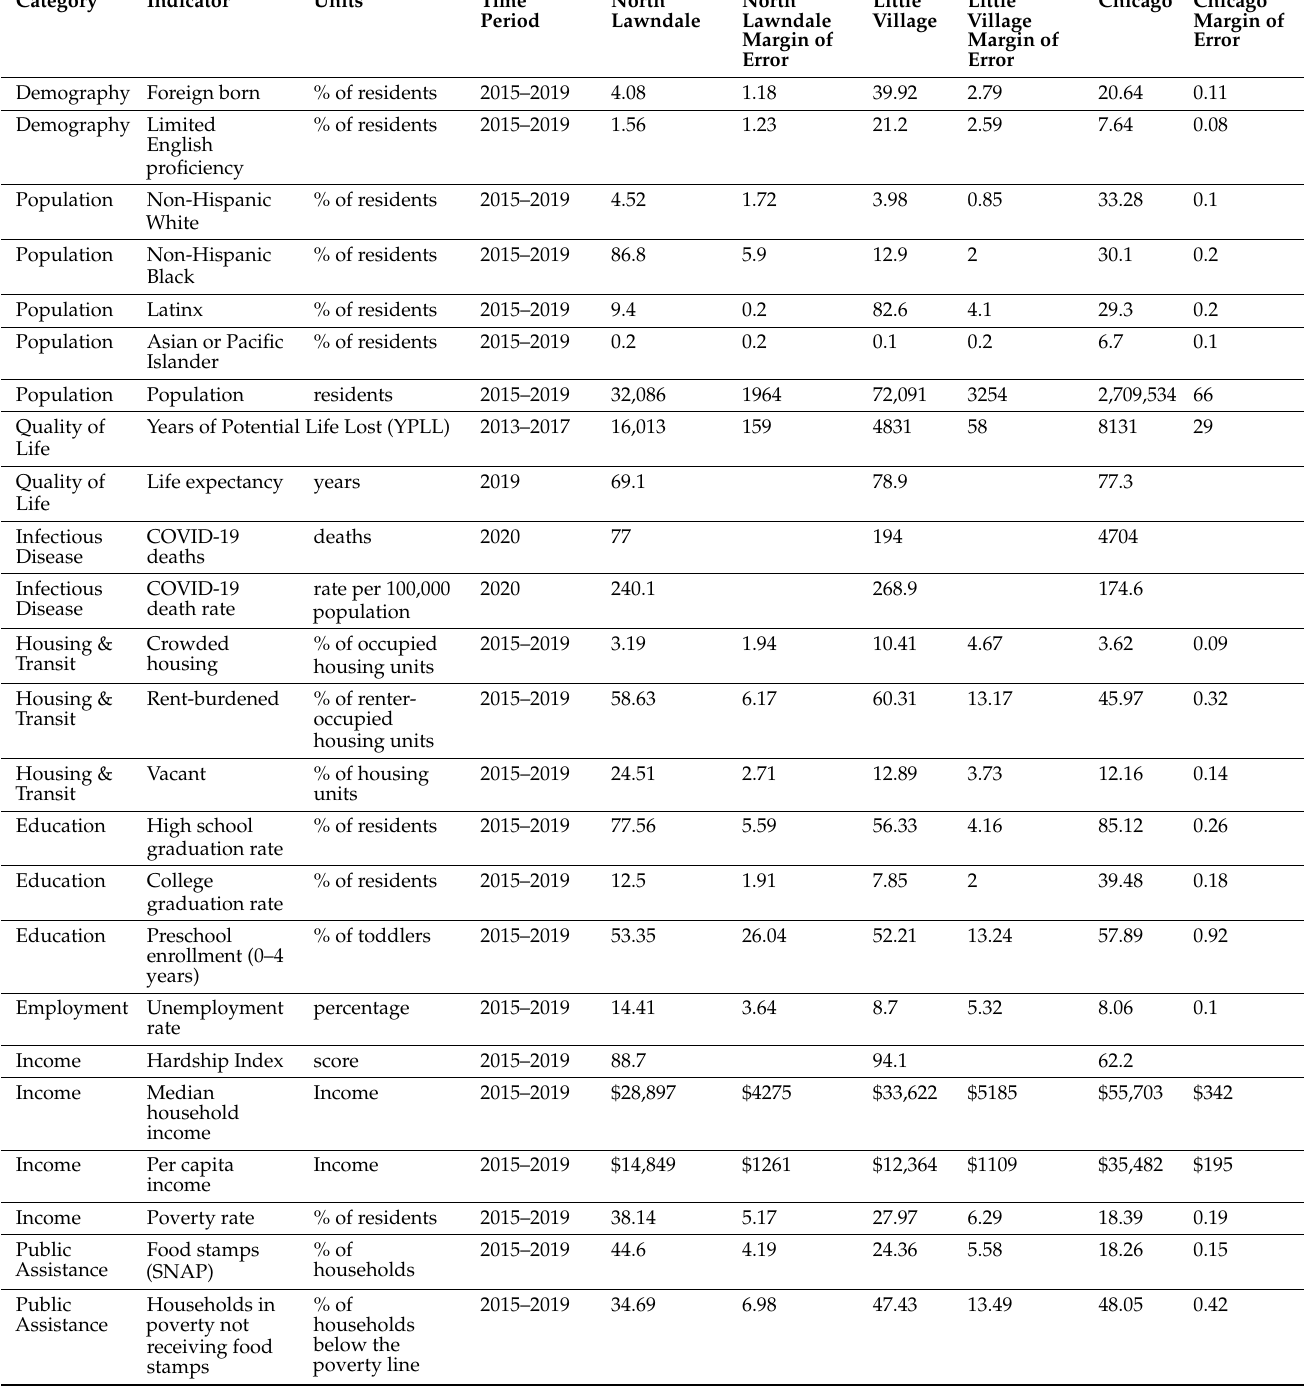
Table 1. Comparison of Socio-demographic Characteristics of North Lawndale, Little Village, and